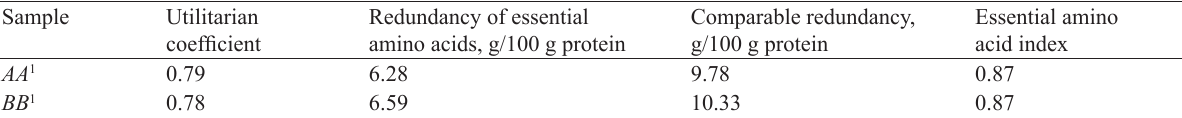
Table 4 Balance of amino acid composition of whole milk from cows with different CSN3 genotypes Sample Utilitarian Redundancy of essential coefficient amino acids, g/100 g protein